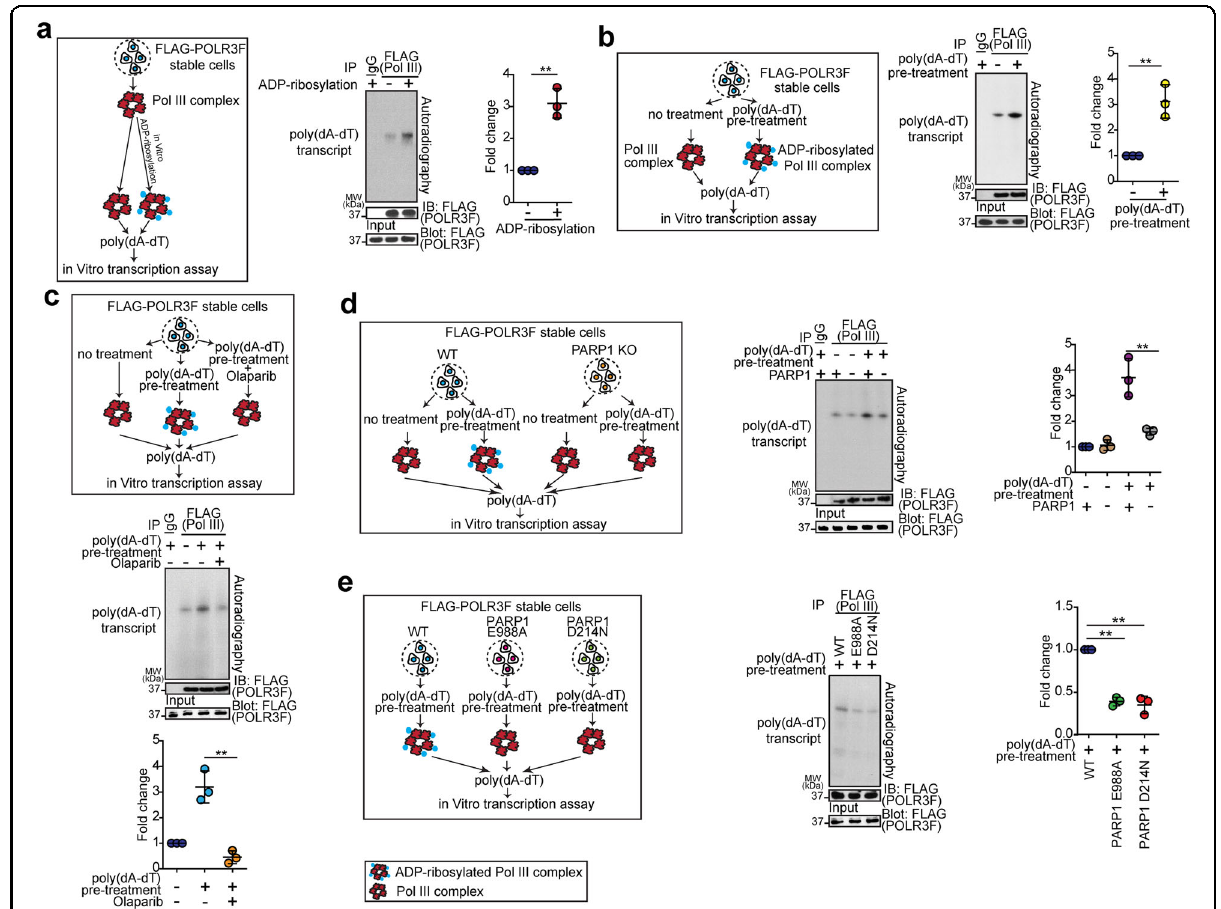
Fig. 6 tPARP1 enhances the activity of Pol III during apoptosis. a The enzymatic activity of ADP-ribosylated Pol III was examined through in vitro Pol III transcription assay. The Pol III complex was puri fi ed from U2OS cells stably expressing FLAG-POLR3F and ADP-ribosylated by tPARP1 in vitro. In vitro Pol III transcription assay was performed with 32 P-UTP. The expression of POLR3F was used as a loading control for IP. IgG was used as the negative control for IP in lane one. b The enzymatic activity of Pol III in apoptotic cells was examined. U2OS cells stably expressing FLAG-POLR3F were treated with or without poly(dA-dT). c The enzymatic activity of Pol III in apoptotic cells was examined when U2OS-POLR3F cells were treated with or without 1 µM olaparib for 1 h. d The enzymatic activity of Pol III was examined in wild-type or PARP1 knockout U2OS cells. e The enzymatic activity of Pol III was examined in the PARP1-null cells reconstructed with wild-type PARP1, the E988A mutant (catalytic-dead mutant), or the D214N mutant (caspase 3-resistant mutant). Note that the apoptotic cells were harvested after 6-h treatment with 5 μ g/mL poly(dA-dT) in b – e . Data are represented as means ± SD as indicated from three independent experiments. Signi fi cance of differences was evaluated by Student ’ s t -test. ** P <